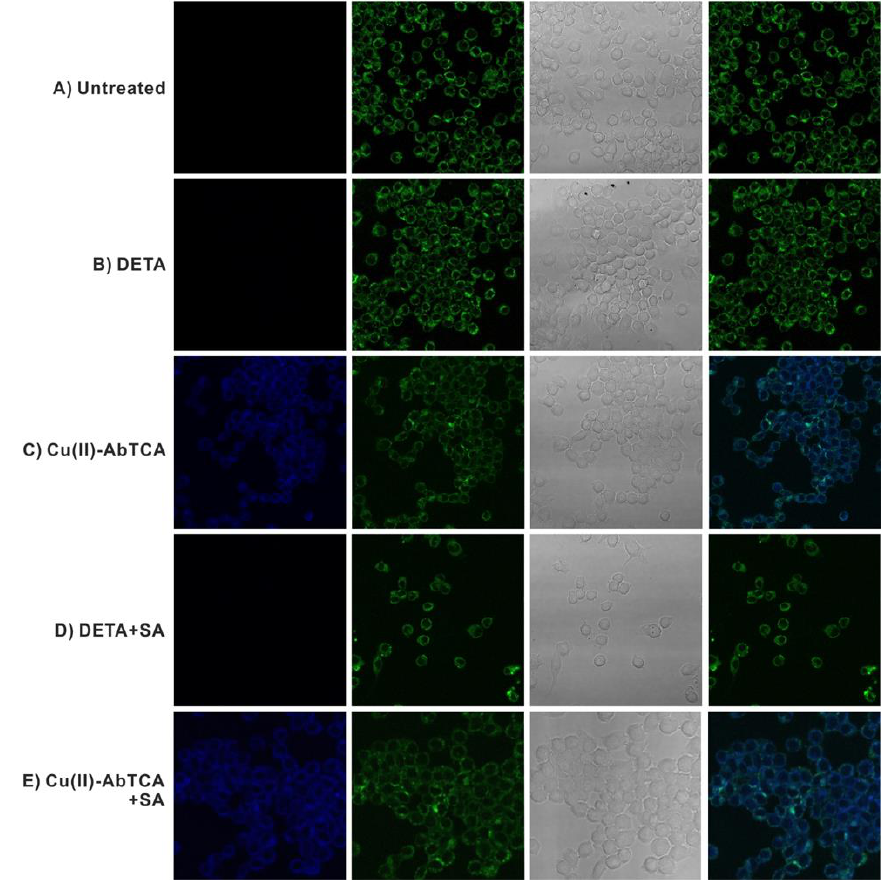
Figure 3. Confocal microscopy images of HNO in live RAW 264.7 cells as detected using Cu(II)-AbTCA (20 µM). Fluorescence images ( left ); Cytoplasm images ( middle ); Bright field images ( middle ); Merged images ( right ). ( A ) RAW 264.7 cells alone; ( B ) Cells treated with DETA NONOate; ( C ) Cells treated with Cu(II)-AbTCA; ( D ) Cells pretreated with Cu(II)-AbTCA followed by DETA NONOate and SA; ( E ) Cells pretreated with Cu(II)-AbTCA followed by SA.